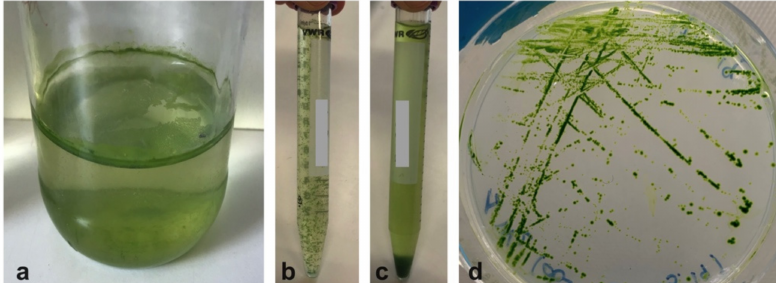
Figure 9. Microalgal material grown in the UWW during the isolation procedure. ( a ) Jar showing two layers containing algal material, an upper one and a lower one. ( b ) Microalgae separated from the upper layer. ( c ) Microalgae separated from the lower layer. ( d ) Example of a Petri dish with isolated colonies of Chlorella -like microalgae. No bacteria contamination is